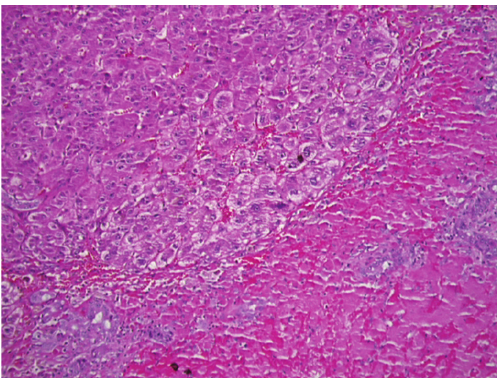
Figure 7: Allograft (100x, H&E section): higher power view of large zones of necrosis abutting adjacent viable hepatic